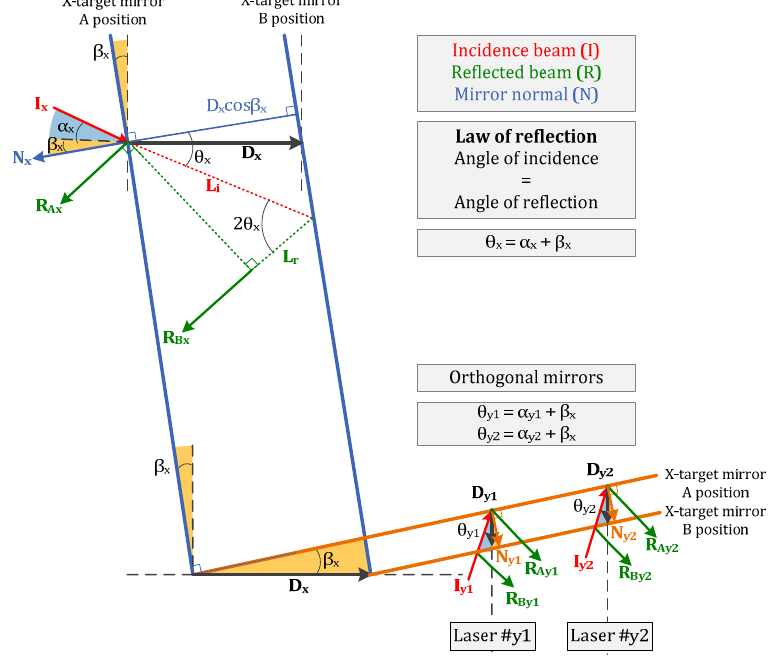
Figure 8. Considered angular deviations due to the laser beams and plane mirrors orthogonality errors in a 2D-motion stage scheme.